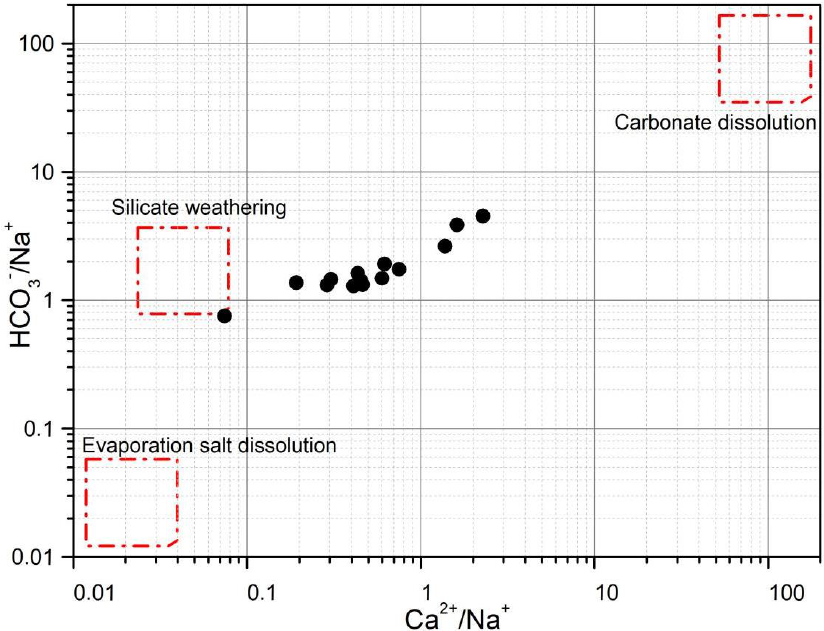
Figure 7. Relationship between Ca 2+ /Na + and HCO 3 − /Na + of the phreatic aquifer in Yongqing County.